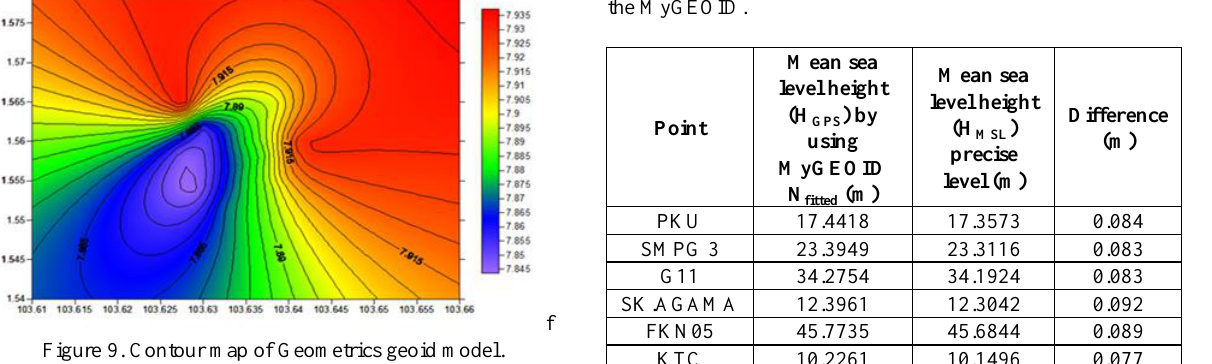
Figure 9. Contour map of Geometrics geoid model.